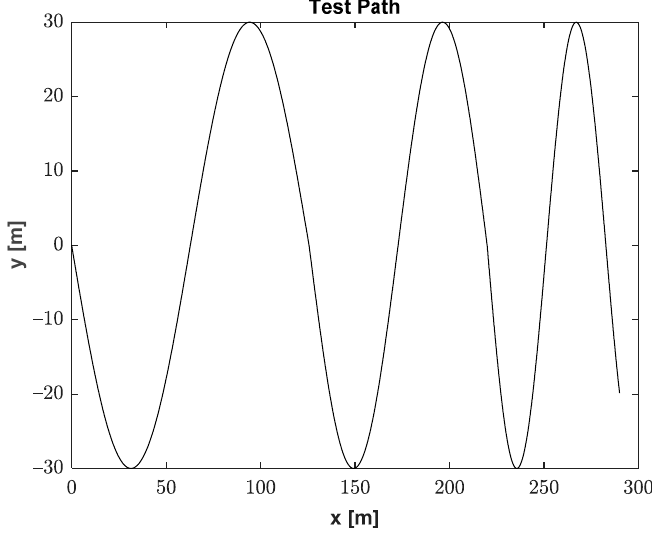
Figure 4. Plot of the test path used in the evaluation of the proposed controller.